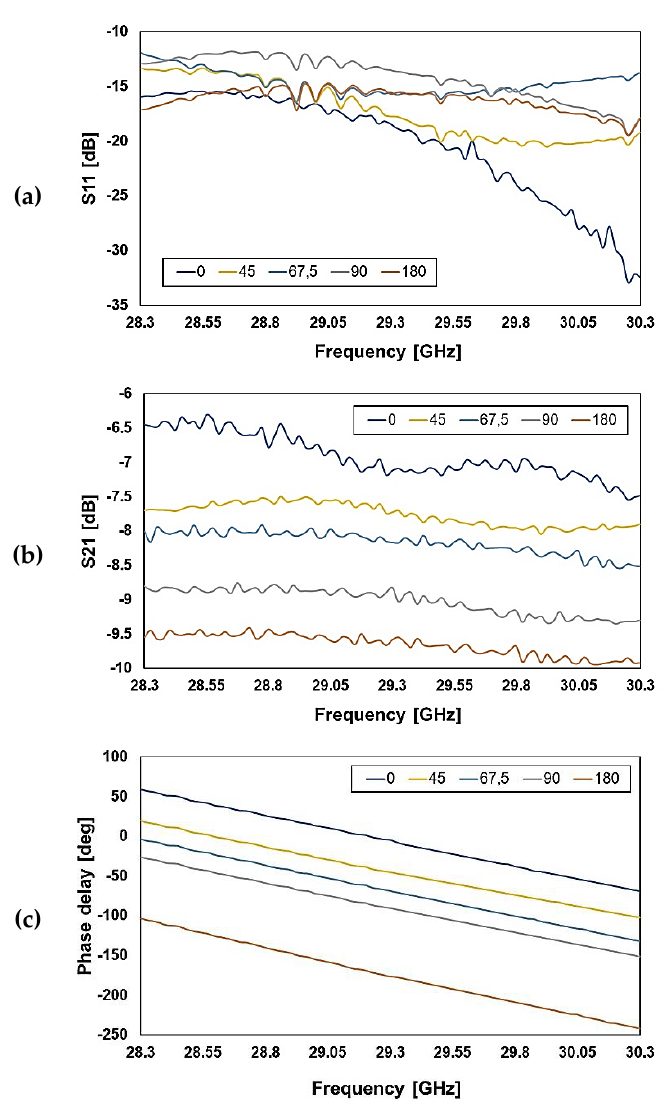
Figure 11. Measured characteristics of the reflection ( a ), transmission ( b ), and phase delay ( c ) for the 29.3 GHz center frequency RF-MEMS phase shifter (Ka band).